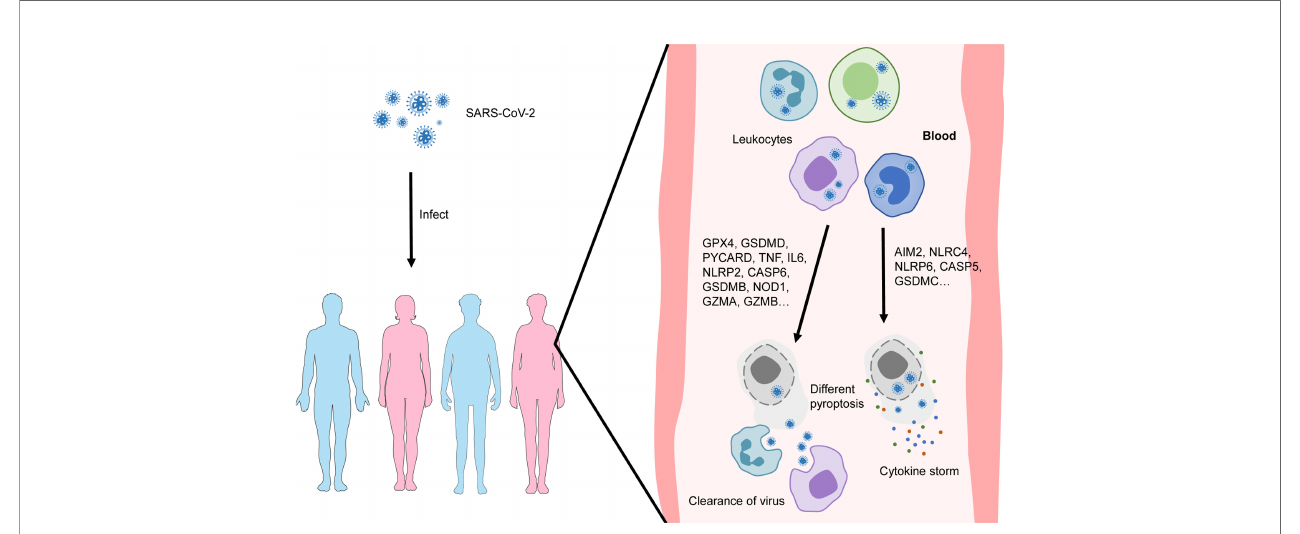
FIGURE 8 | Different patterns of pyroptosis of blood leukocytes in patients with